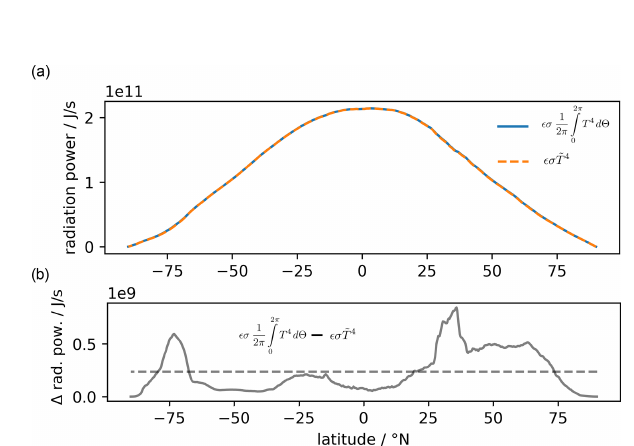
Figure A1. Longwave radiation (cid:15)σT 4 based on hourly near-surface temperatures, generated using Copernicus Climate Change Service information for 1979CE following Hersbach et al. (2020). (a) It 2 π (cid:82) T 4 d(cid:50) ≈ (cid:15)σ ˜ T 4 . (b) The differences are more is seen that (cid:15)σ 1 2 π 0 than 2 orders of magnitude smaller than the mean values. The most pronounced differences are over the subtropics (deserts) and mid- to-high latitudes, where we have a pronounced daily cycle.